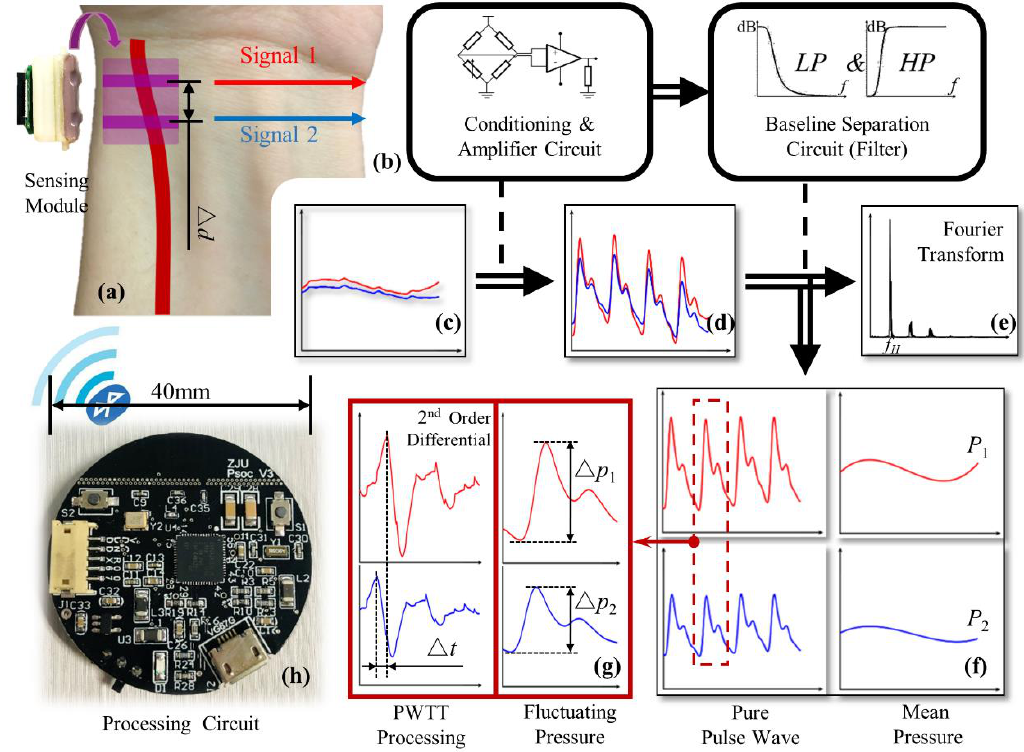
Figure 5. Signal processing flow chart: ( a ) sensing module; ( b ) schematics of conditioning, amplifier, and baseline separation circuit; ( c ) raw pulse signal; ( d ) amplified pulse signal; ( e ) heart rate processing; ( f ) pure pulse wave signal and the mean pressure signal; ( g ) PWTT processing; ( h ) photo of the processing circuit.